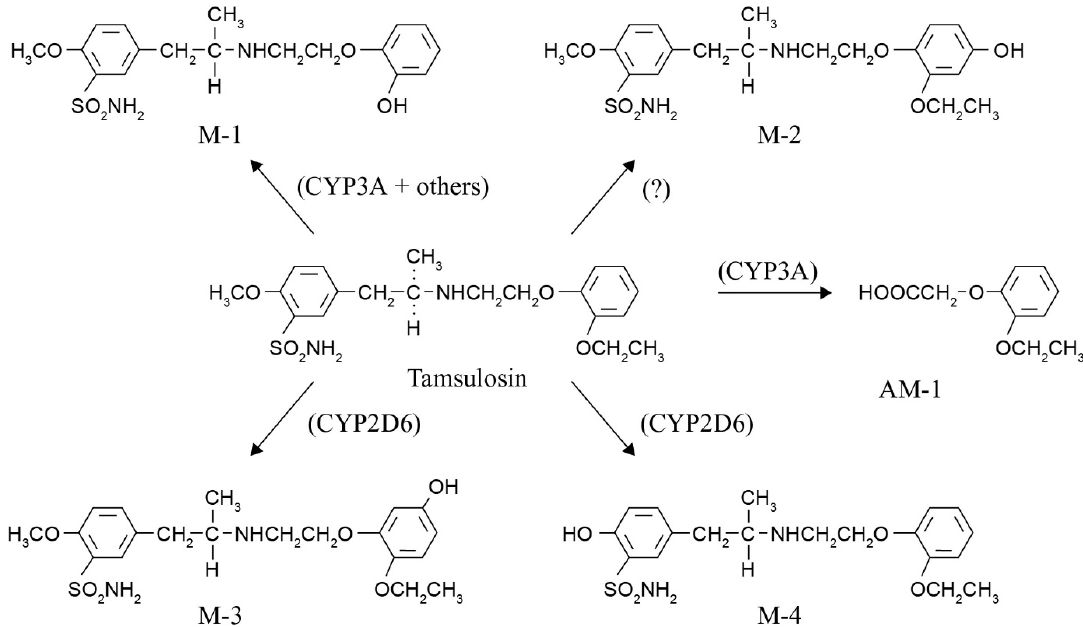
Figure 1. Tamsulosin is metabolized to five known metabolites by cytochrome P450 enzymes, mainly CYP3A4/5 and CYP2D6. After oral administration, M-1 is the major product (15.7% of the dose), followed by AM-1 (7.5% of the dose) and M-3 (6.4% of the dose). The formation of tamsulosin metabolites M-1 and AM-1 is mainly catalyzed by CYP3A isoforms (CYP3A4/5). The formation of M-3 is mainly catalyzed by CYP2D6 [8,9].